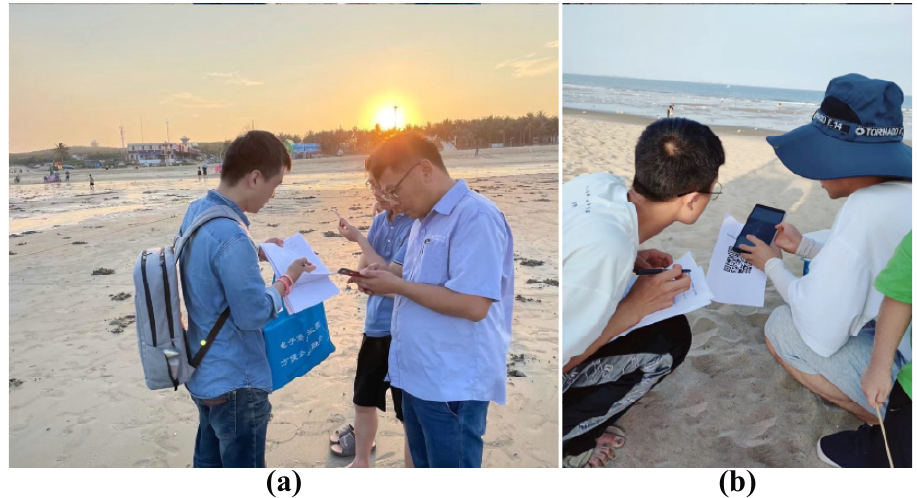
Figure 3. Flow chart of the survey methods. ( a ) Describe the structure and hazards of rips and the means of escape if trapped in a rip current; ( b ) display video showing the phenomenon of rips.